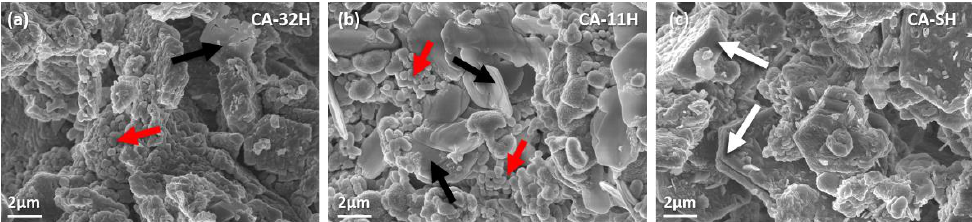
Figure 12. SEM images, magnification = 100 k, for CA-32H ( a ), CA-11H ( b ) and CA-SH ( c ) after five dehydration-hydration cycles.